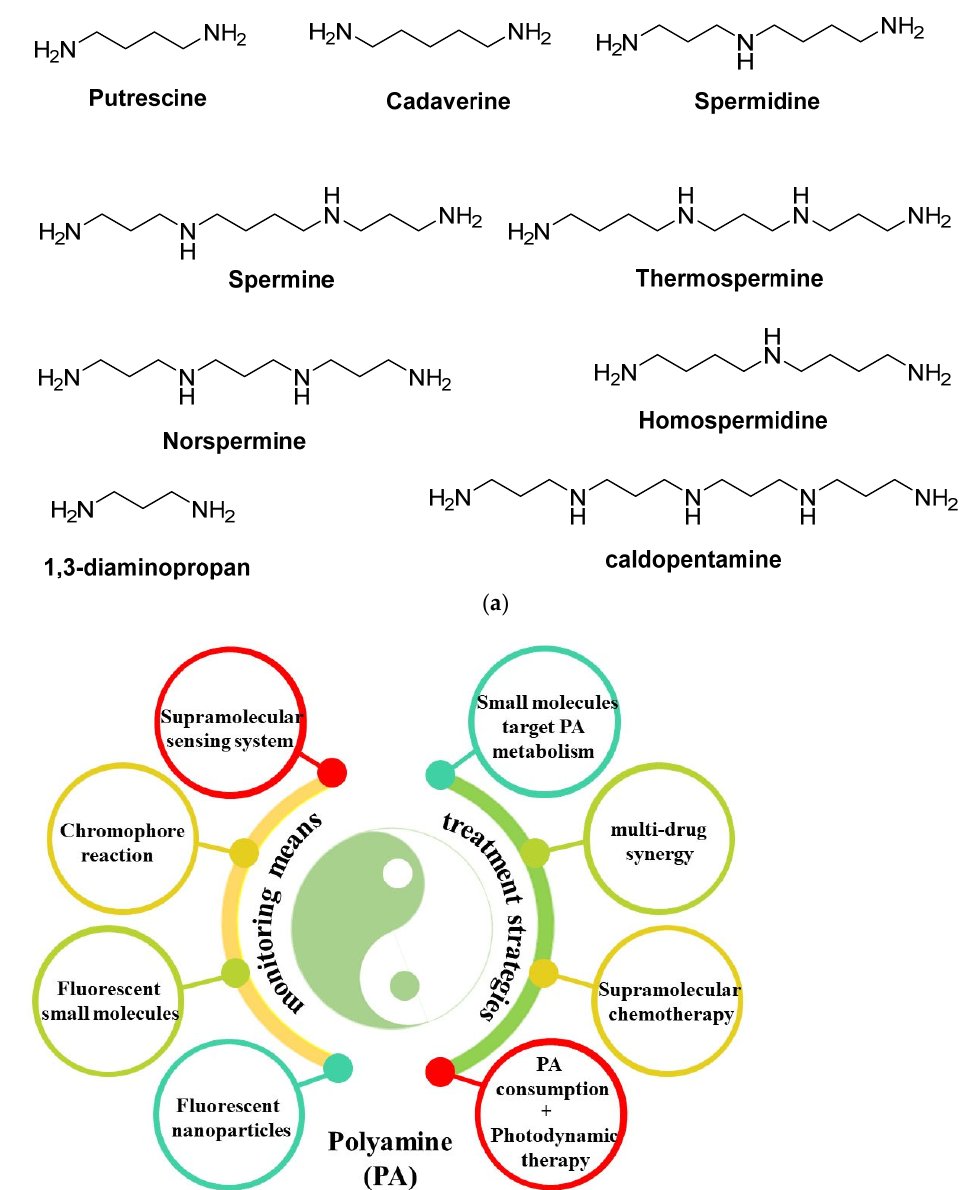
Figure 1. ( a ) Chemical structures of polyamines and their homologs. ( b ) A cartoon diagram of the polyamine fluorescence detection and polyamine suppression strategy in tumor treatment.